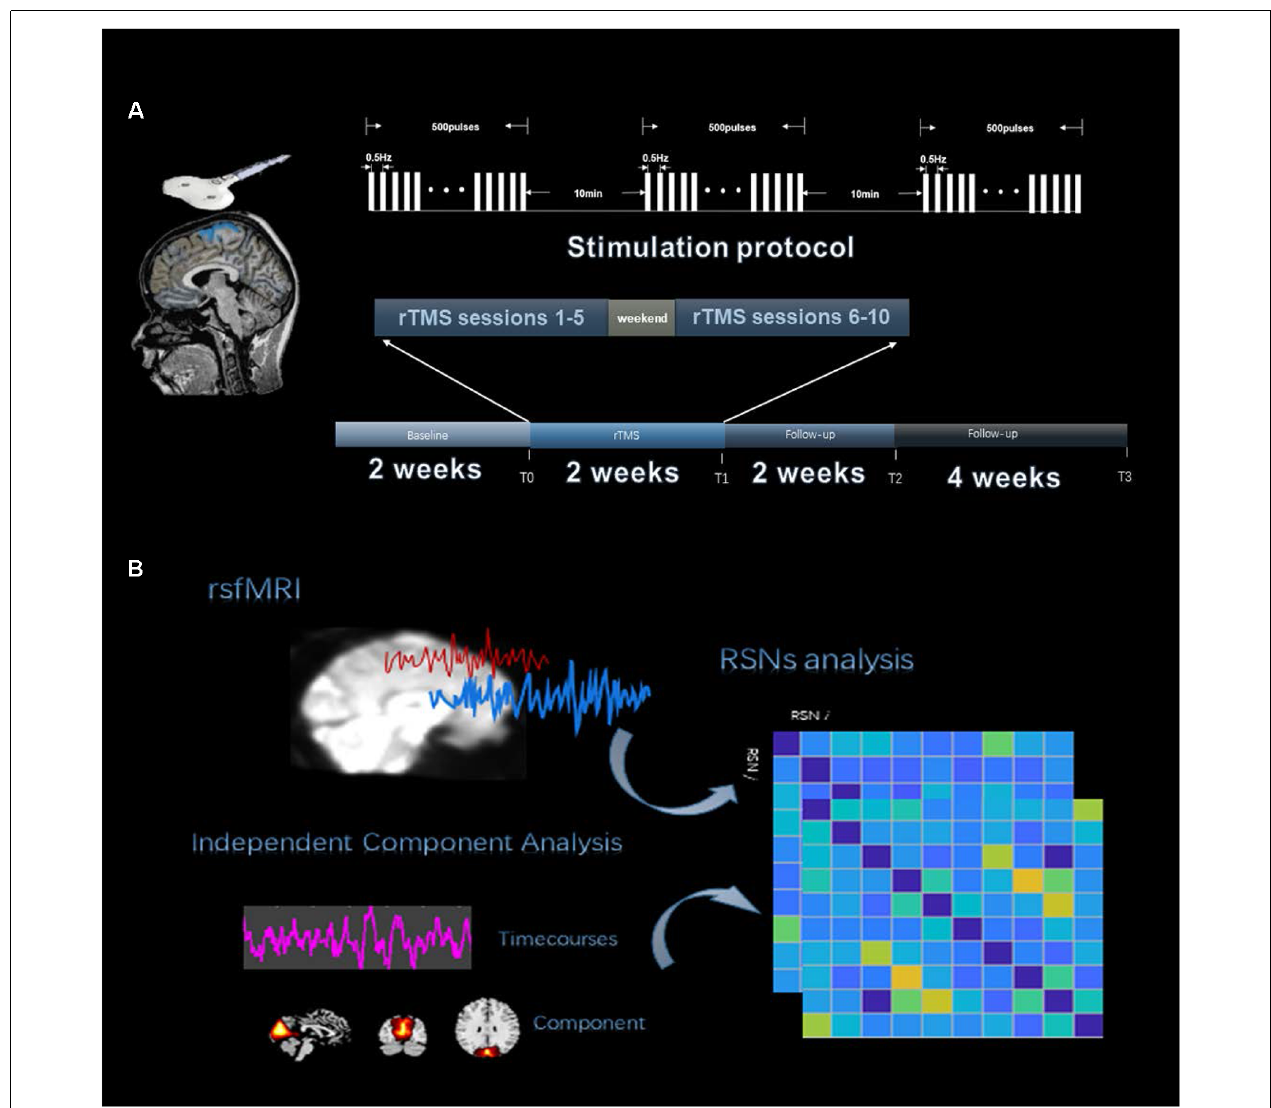
FIGURE 1 | Experiment procedure. (A) The four time points were designed into the timeline of the study, which were T0, T1, T2, and T3. Repetitive transcranial magnetic stimulation (rTMS) 10 sessions with the stimulation protocol are shown above the timeline. (B) The analysis process of functional network connectivity (FNC) divided into three steps, including fMRI data preprocessing, resting-state network (RSN) identification by independent component analysis (ICA) and extracting RSN time courses to calculate Pearson’s